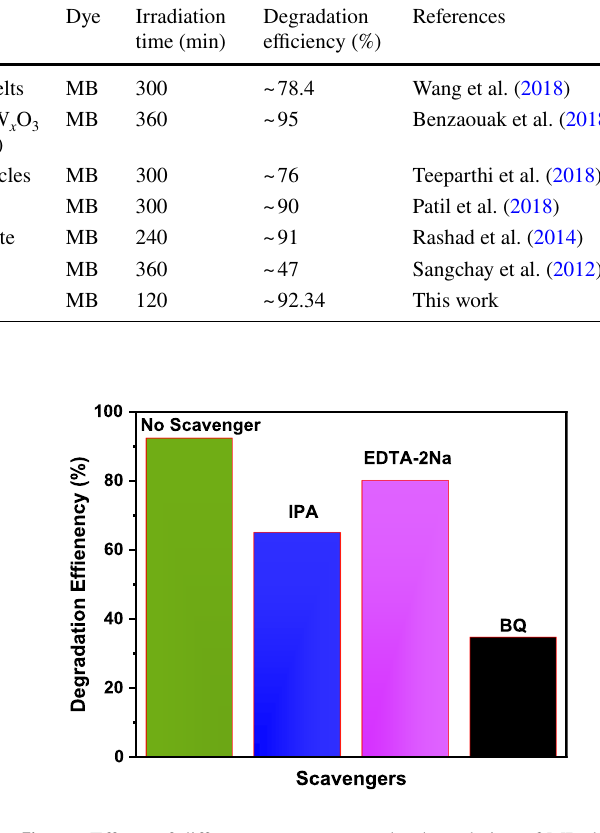
Fig. 13 Effects of different scavengers on the degradation of MB dye in the presence of 4% Y-doped SnO 2